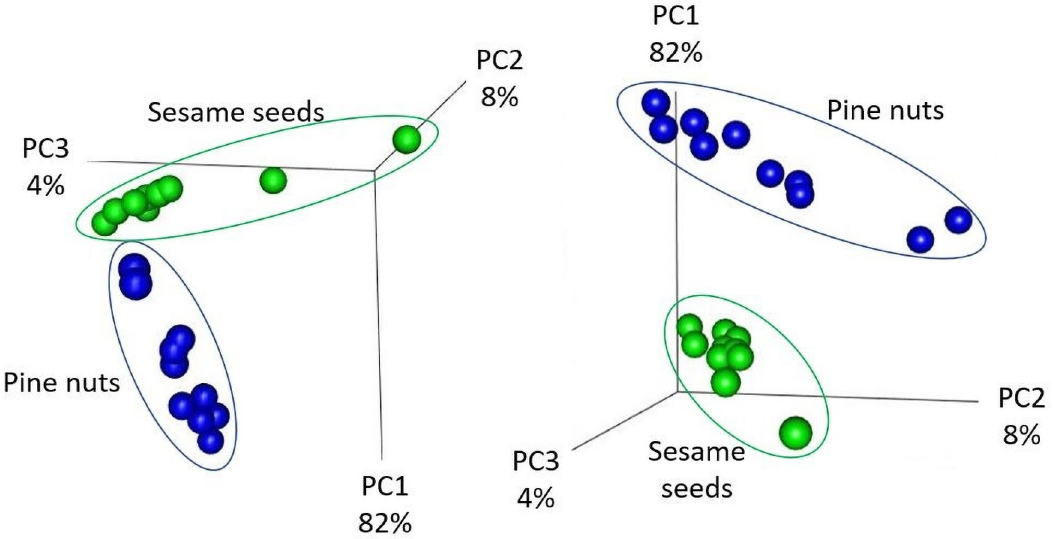
Fig 2. Principal coordinates analysis (PCoA) of the seed samples used in this study using the weighted UniFrac community distance metric. The 10 sesame seed brands (green) and pine nut brands (blue) cluster